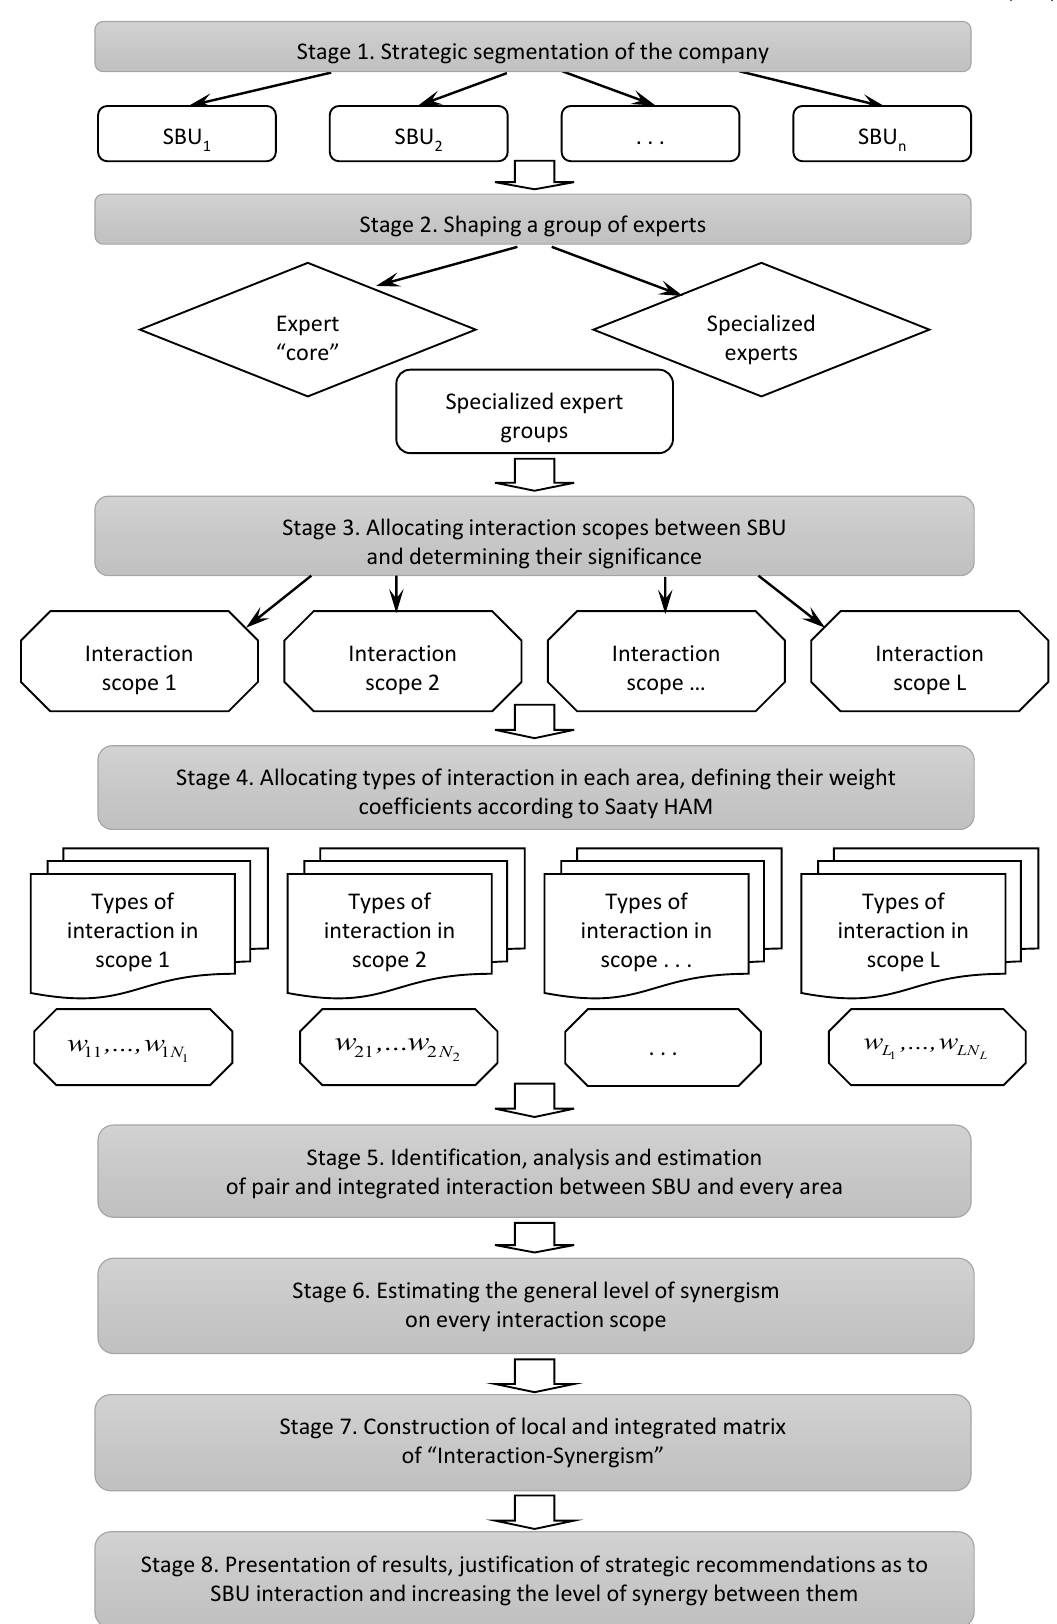
Figure 1. Simulation management model of SBU synergic interaction of diversified